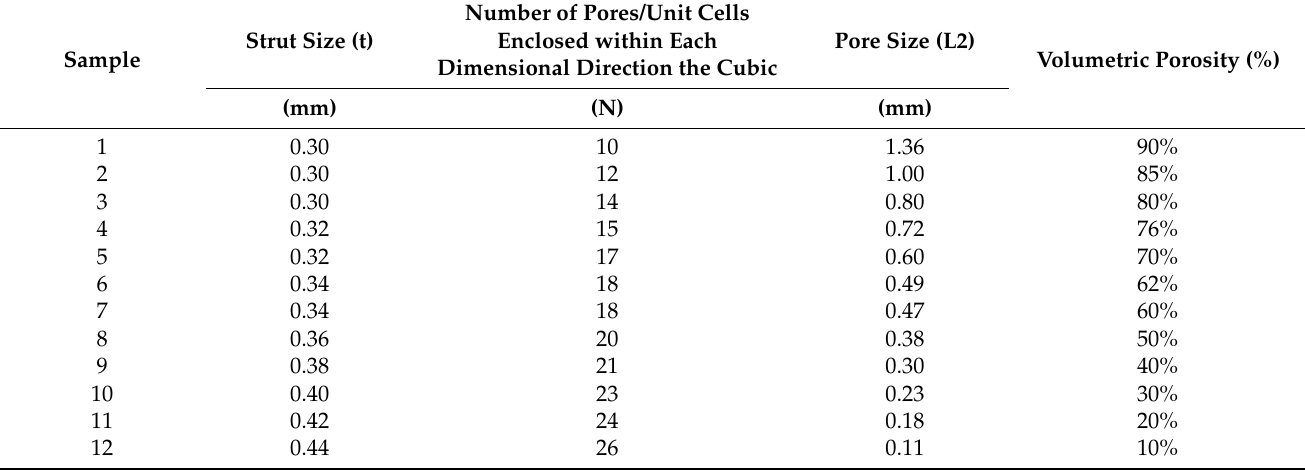
Table 1. Designed samples of porous cubes with the relevant volumetric porosities and obtained mechanical properties from the